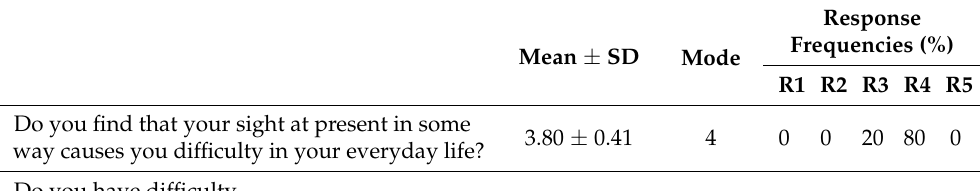
Table 4. Summary of 25 patients’ reported difficulties with their vision as per the Catquest-9SF. Response coding: R1 (yes, very great difficulty), R2 (yes, great difficulty), R3 (yes, some difficulty), R4 (no, no difficulty), R5 (cannot decide). SD: standard deviation.